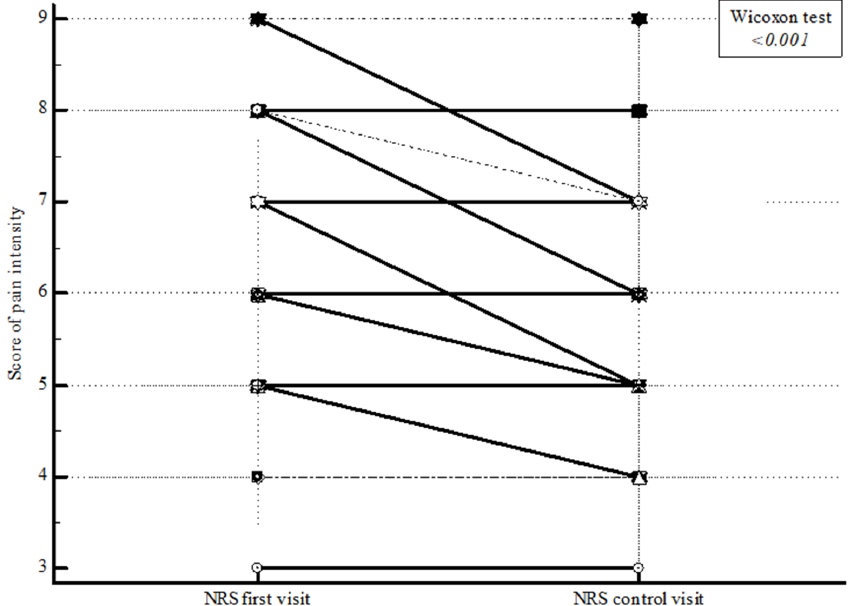
Figure 2. The reduction of pain intensity.